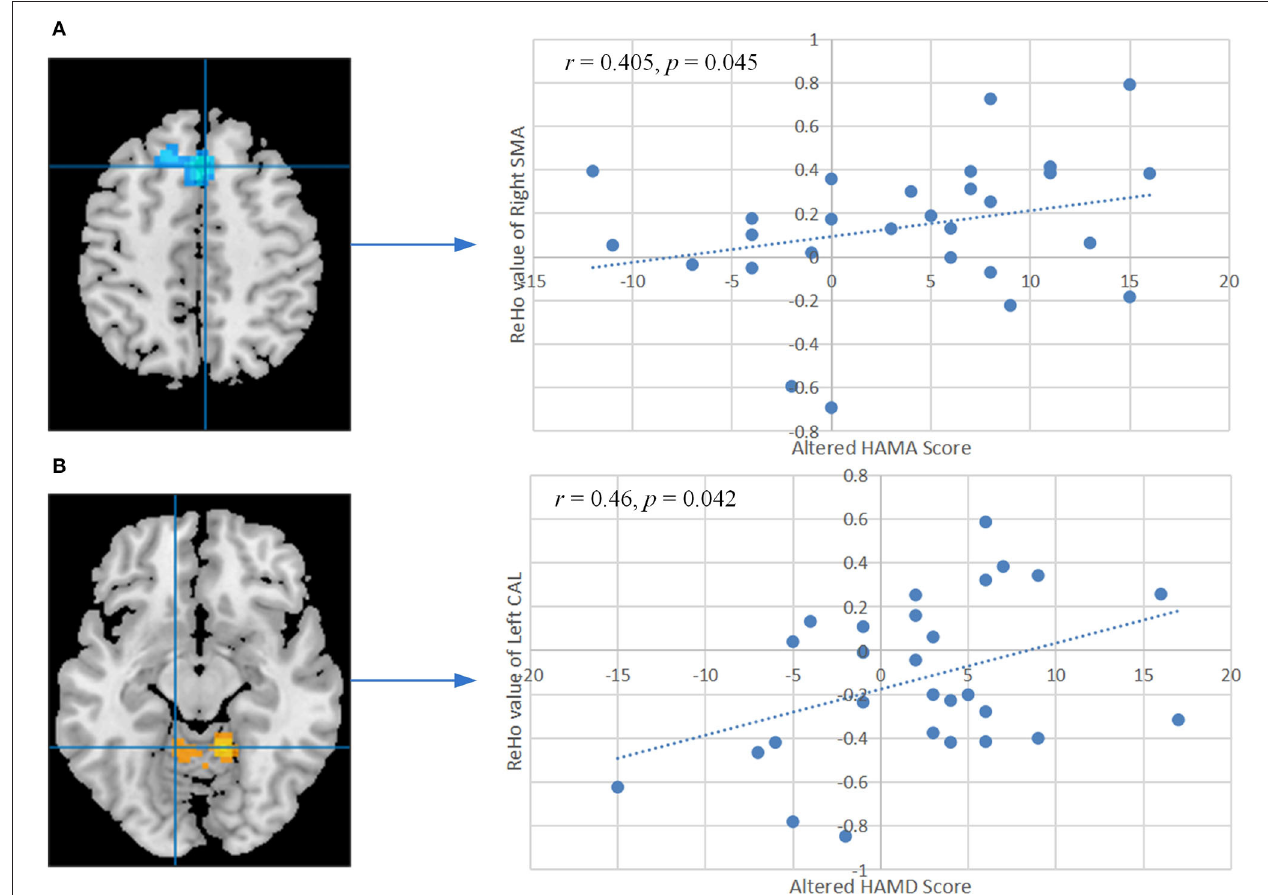
FIGURE 4 | (A) Correlation between the altered HAMA score and ReHo values of the right SMA after training. (B) Correlation between the altered HAMD score and ReHo values of the left CAL after training. The P- values were corrected by the false discovery rate. ReHo, regional homogeneity; HAMA, Hamilton Anxiety Scale; HAMD, Hamilton Depression Scale; SMA, supplementary motor area; CAL, cerebellum anterior